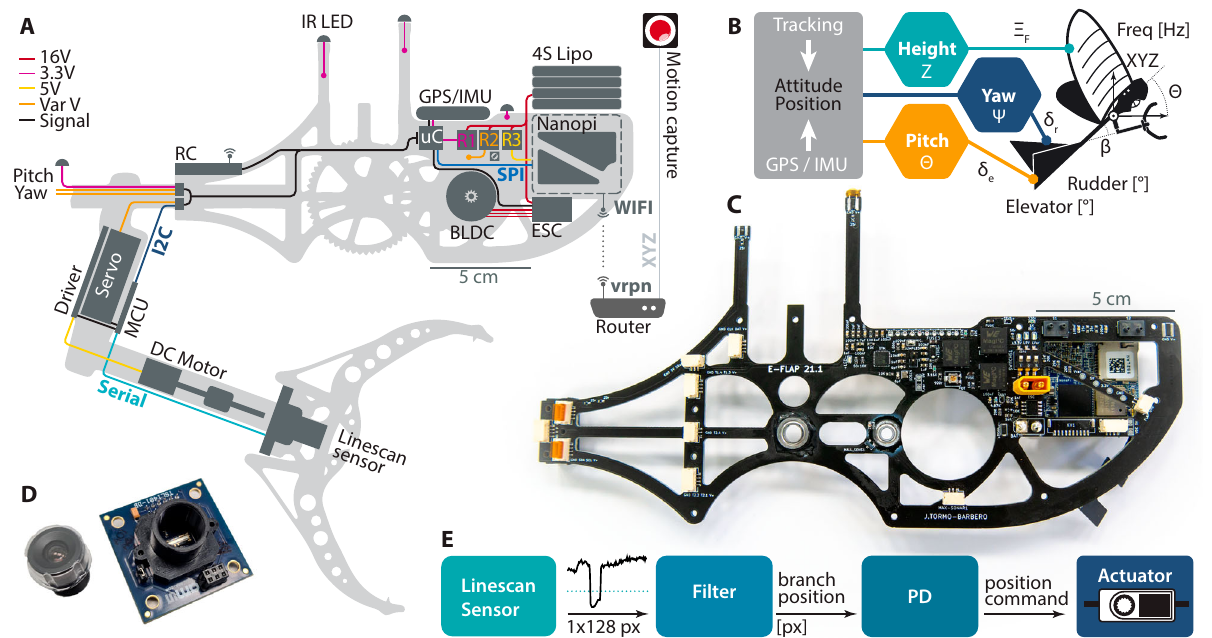
Fig. 3 | Avionics and control of the P-Flap. A Electronics layout of the perching robots, showing components and connections. This includes communication buses (Serial, I2C, SPI, VRPN), active electronics (microcontrollers MCU and uC, regulators R1, R2, R3, light-emitting devices IR LED) and stand-alone components (inertial-measurement unit GPS/IMU, brushless electric motor BLDC, electronic driver ESC and battery (4S Lipo)). B Triple control strategy that running on the